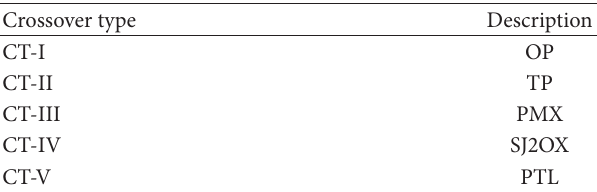
Table 1: Crossover type. Table 2: Comparisons of different crossover